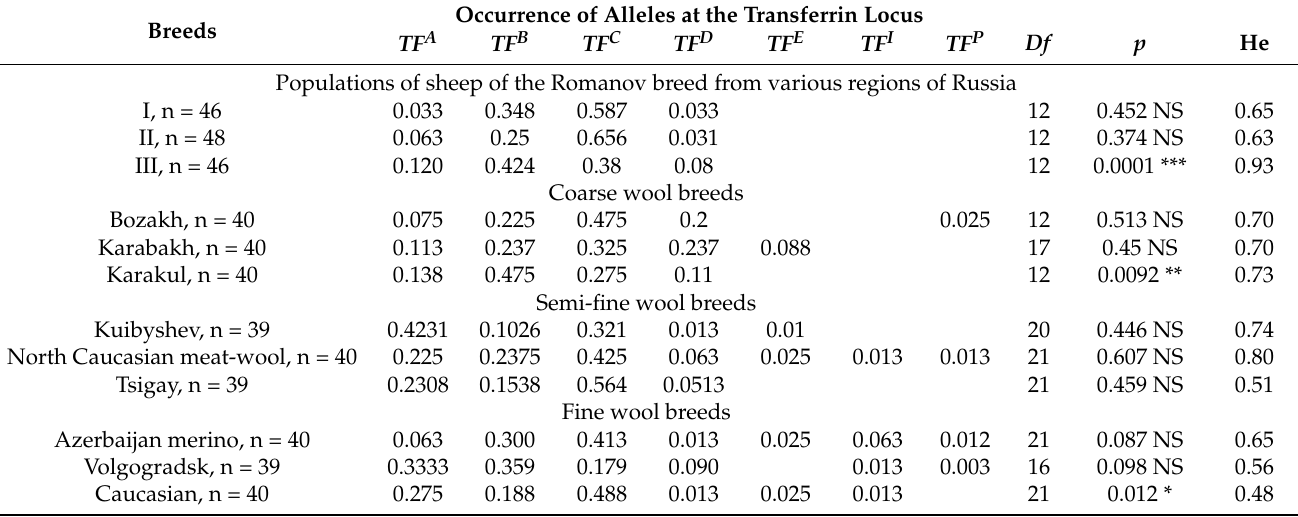
Table 6. Occurrence of alleles and the status of genetic equilibrium in the transferrin ( TF ) locus in sheep of various breeds (n = 497). Fisher’s exact tests were performed on the genotype occurrences for each population (see Table 4 in Marzanov et al. [9]). He =